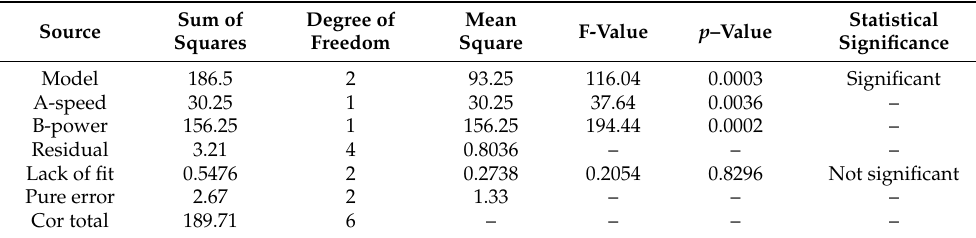
Table 3. Analysis of variance (ANOVA) for the linear model obtained for the initial WCAs. Sum of Degree of Mean Source Squares Freedom Square